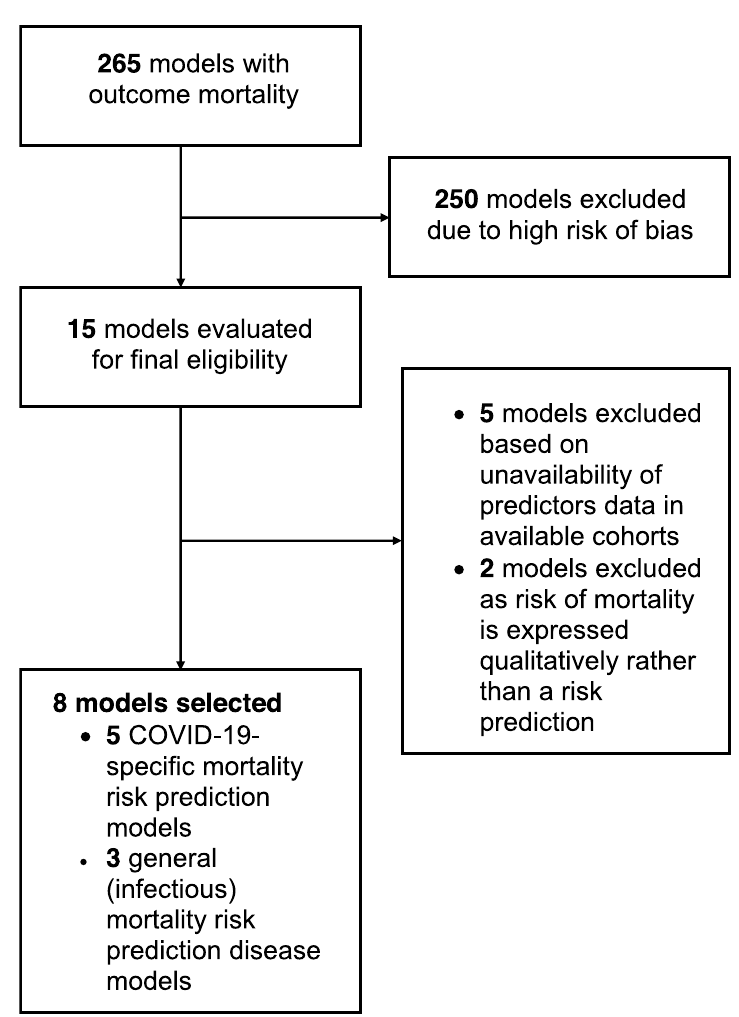
Fig. 1 Flowchart for inclusion of prognostic models for external